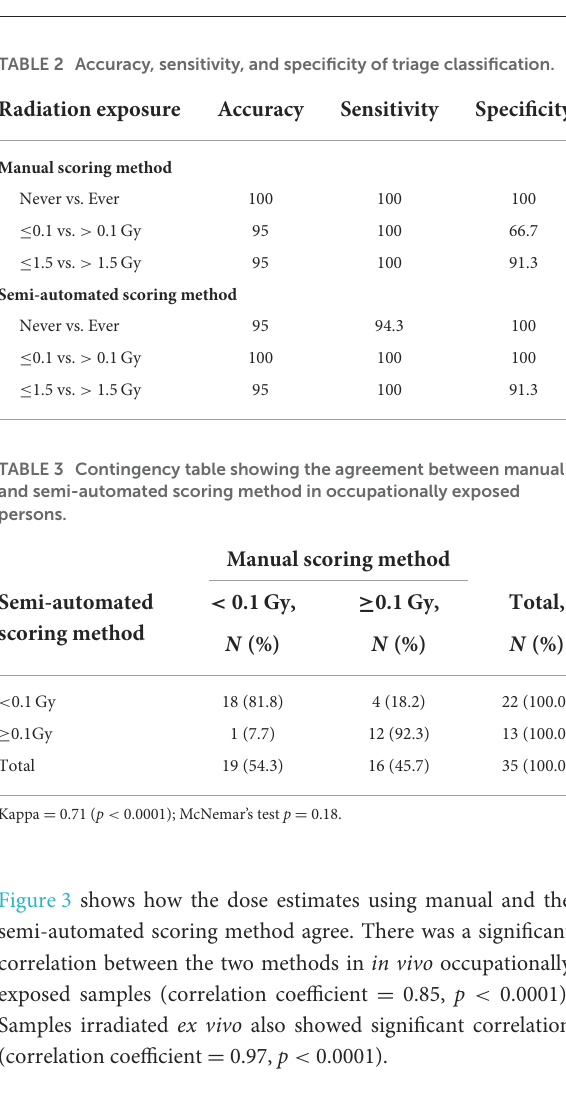
FIGURE2 Estimated doses by DCScore software. Each data point represents the dose estimate by conventional manual DCA (open circles) and DCScore-based semi-automated scoring method (filled circles). The solid lines represent ± 0.5Gy intervals.